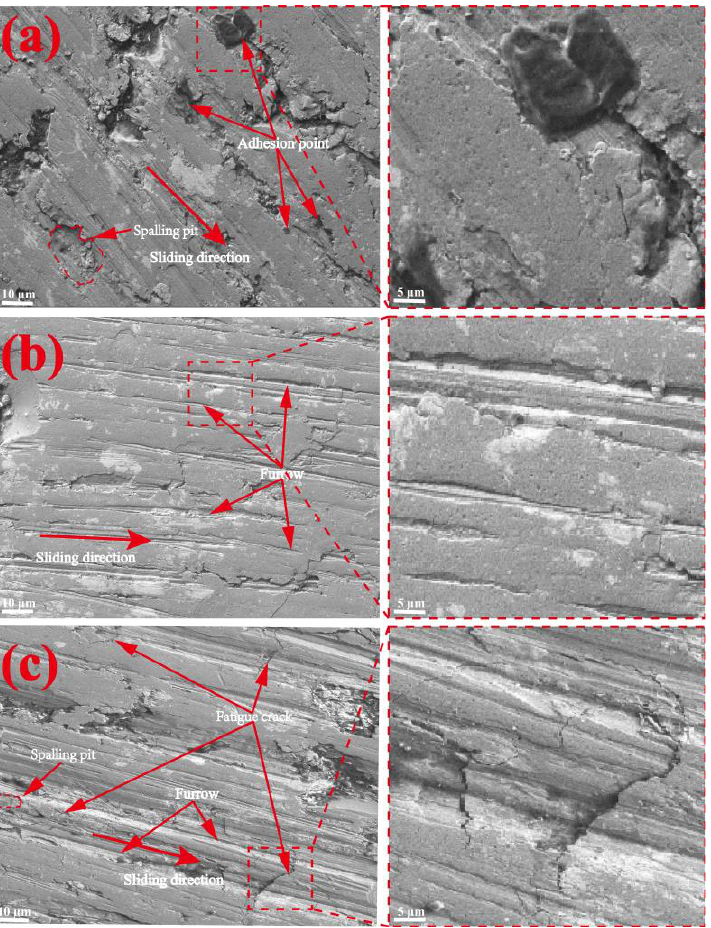
Figure 12. Wear morphology of coatings with different preloading depths: ( a ) HT + UDR + 0.20 mm; ( b ) HT + UDR + 0.25 mm; ( c ) HT + UDR + 0.30 mm.